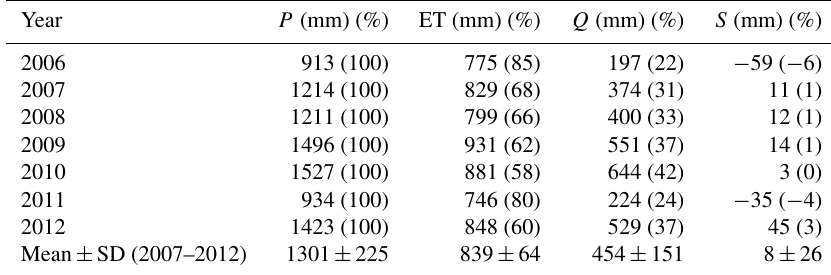
Figure 6. (a) LAI and SAI forcings for tree and herbaceous covers. (b–e) Observed and simulated evapotranspiration over herbaceous cells (b) and tree cells (c) for the reference simulation and the saprolite simulation ( d and e ). Blue line shows the spatial average over all cells of the respective cover out of the inland valley, and the shaded area shows the extent of spatial maxima and minima. (f) Precipitation. Table 5. Water budgets for the reference case. Mean and SDs are calculated on the period 2007–2012.